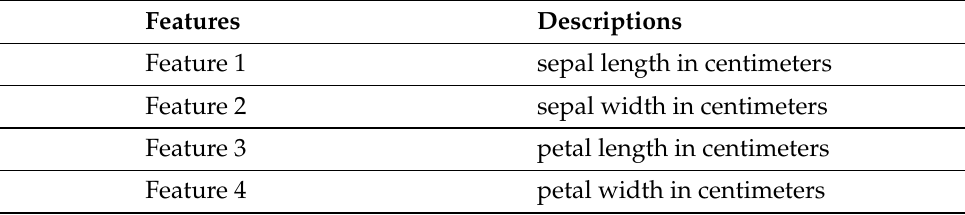
Table A5. Feature description for the Iris